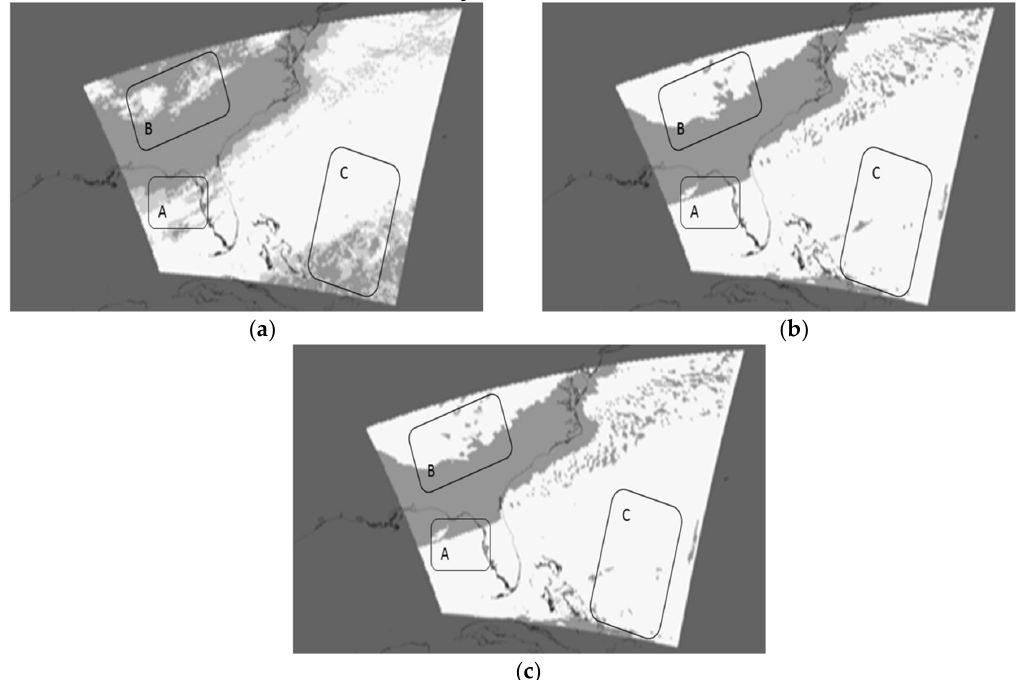
Figure 6. Comparisons between CCf truth and CCf WRF for 24 h WRF simulations valid at 1800 UTC on 19 Nov 2014. ( a ) CCf truth, ( b ) CCf WRFrst (CLDFRAmax) results from baseline (unmodified) WRFrst file for all clouds in the VIIRS data 2014 after mapping the MGCNC image to the WRF grid, and ( c ) CCf WRFrst (CLDFRAmax) results modified WRFrst file. Legends are the same as those used in Figure 3.